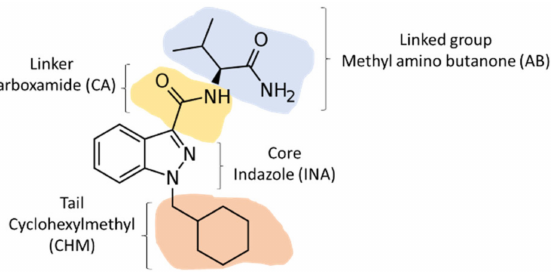
Figure 1. Structure of the synthetic cannabinoid AB-CHMINACA based on the EMCDDA